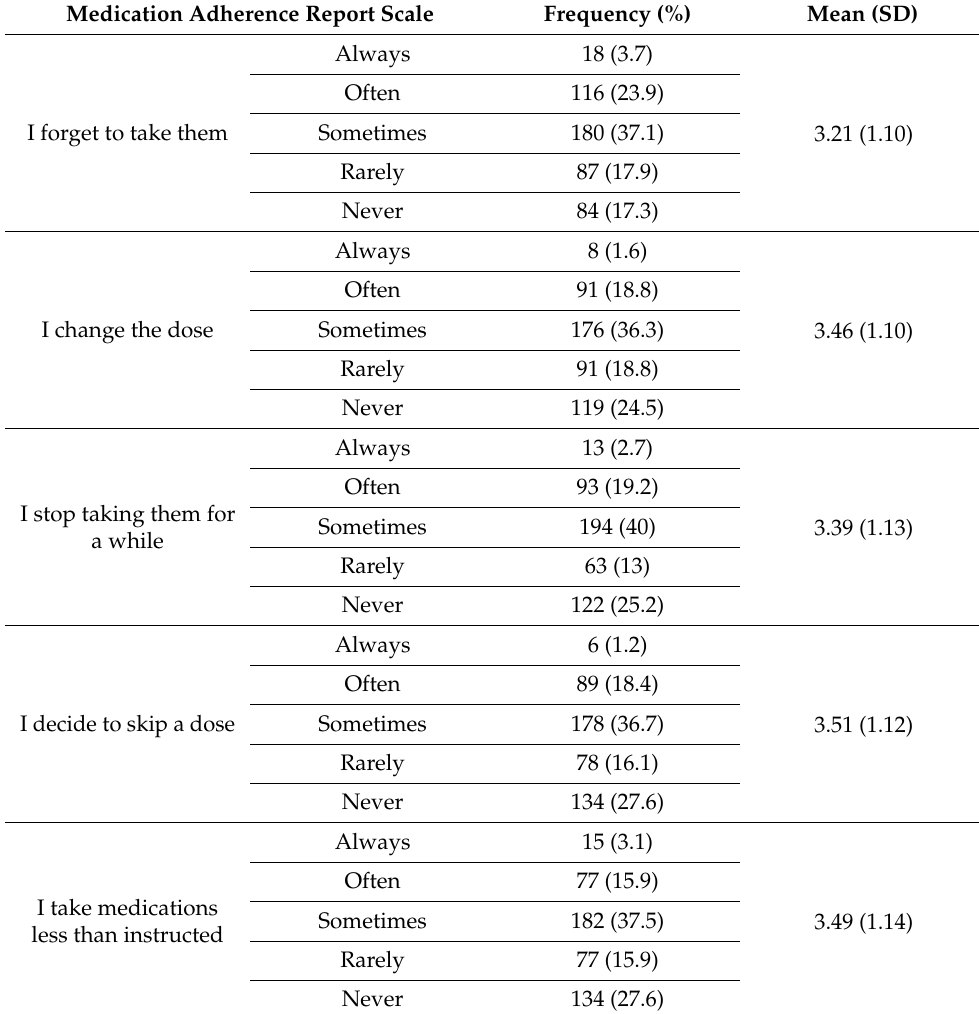
Table 2. Participants’ responses to the MARS-5 questionnaire.